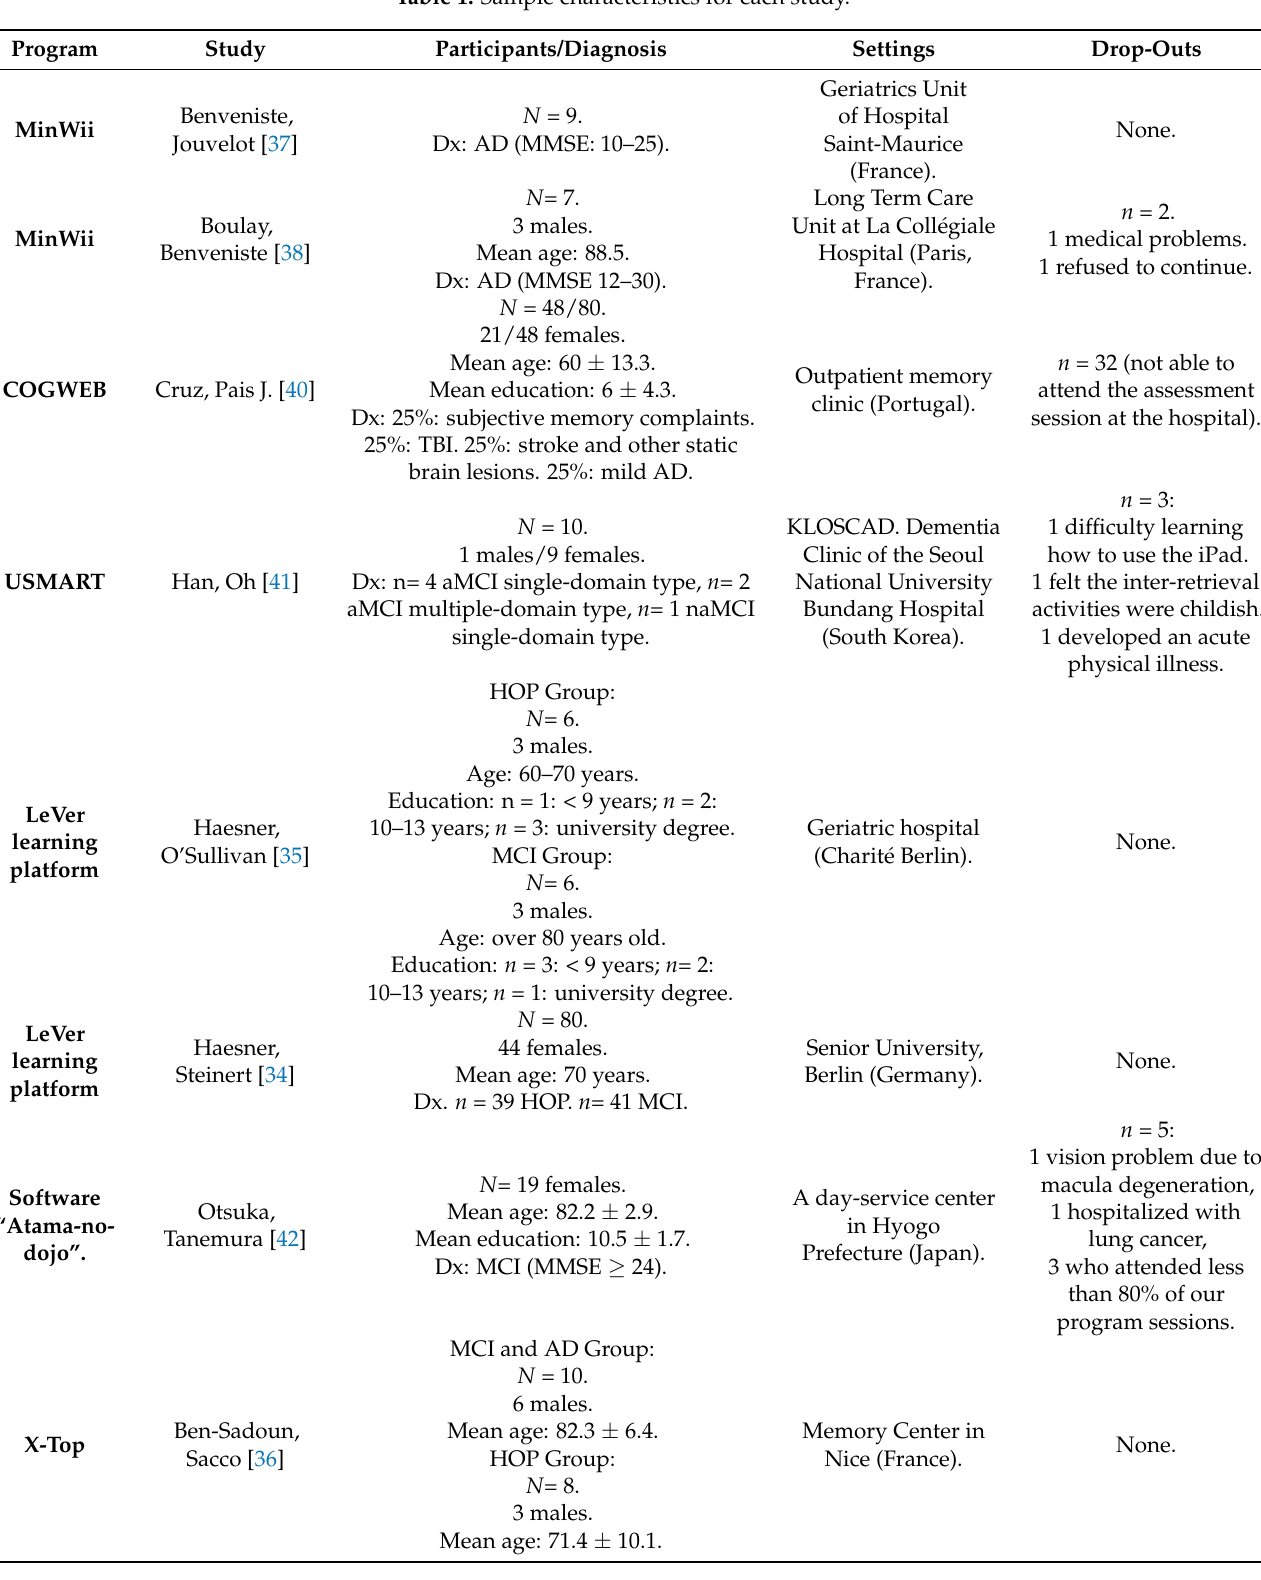
Table 1. Sample characteristics for each